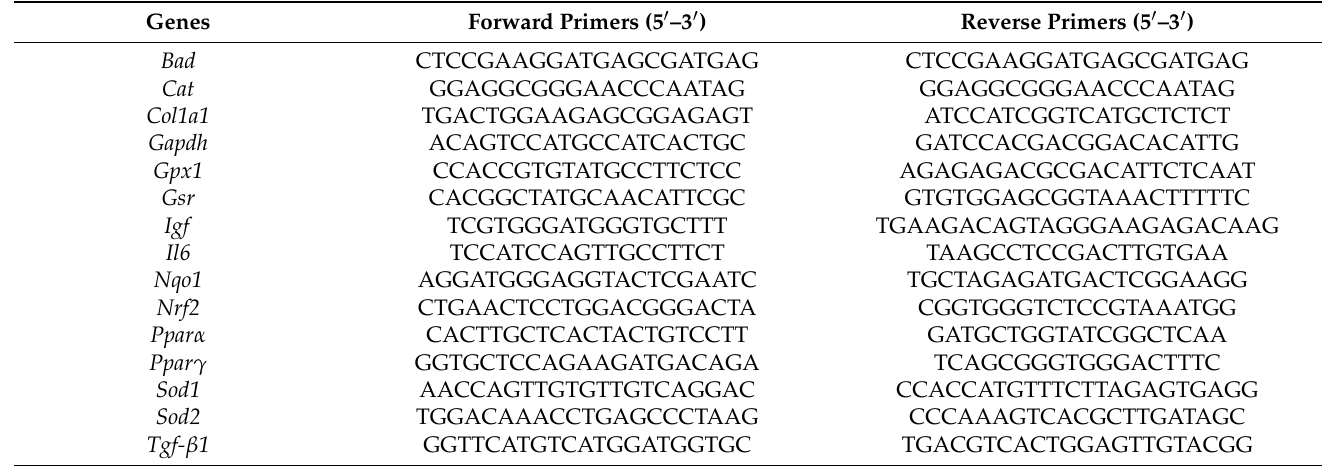
Table 1. Primer sequences used for quantitative real-time